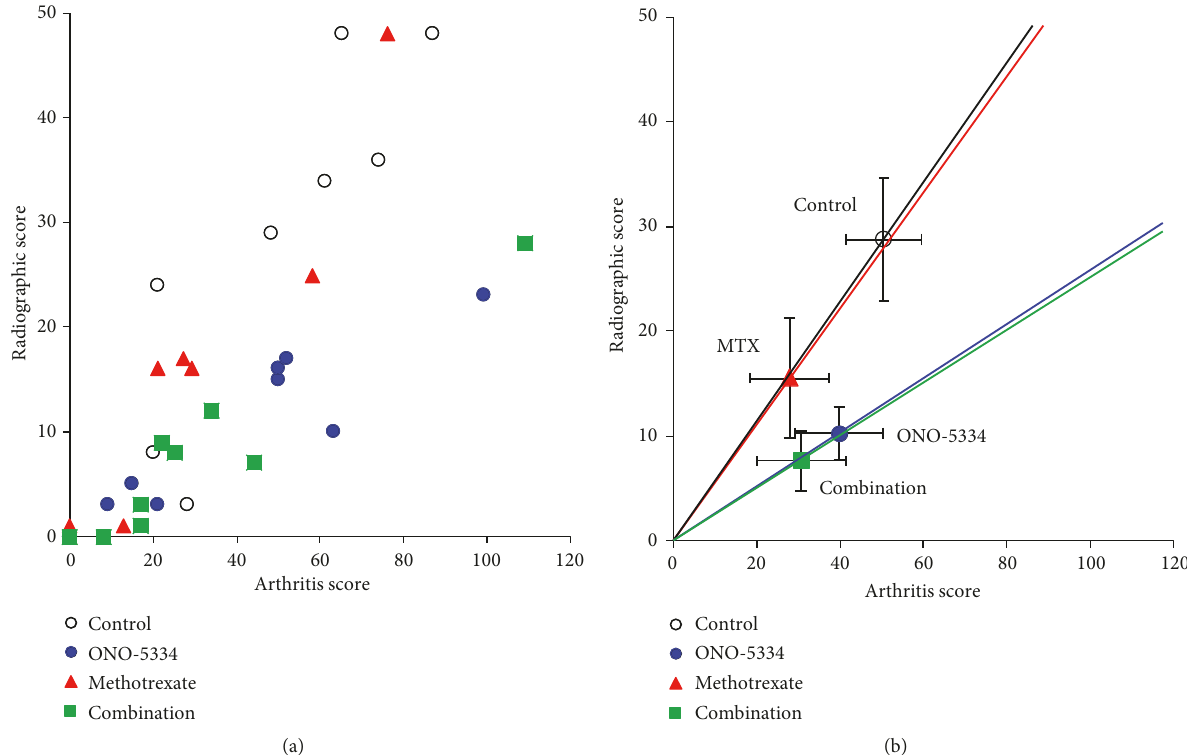
Figure 4: Relation between joint swelling score at peak and X-ray score at day 63 for (a) individual animals and (b) treatment groups in collagen-induced arthritis monkeys. Data are expressed as mean ± SE; control (n=8), ONO-5334 (n=9), methotrexate (n=8), and combination